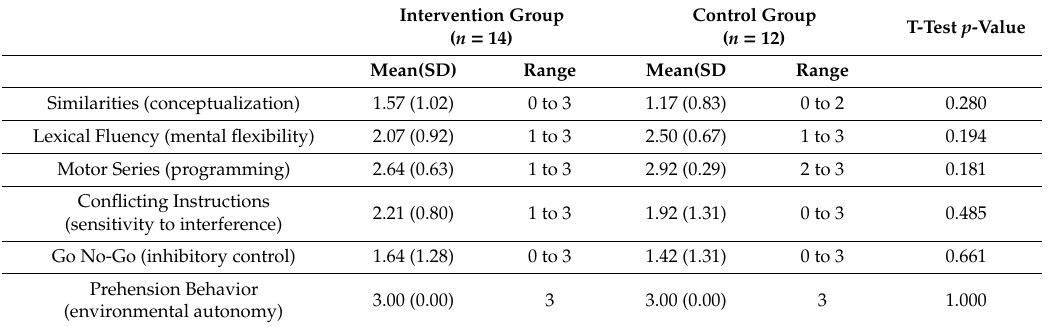
Table 3. Frontal Assessment Battery (FAB) subscores in the intervention and control groups at baseline.